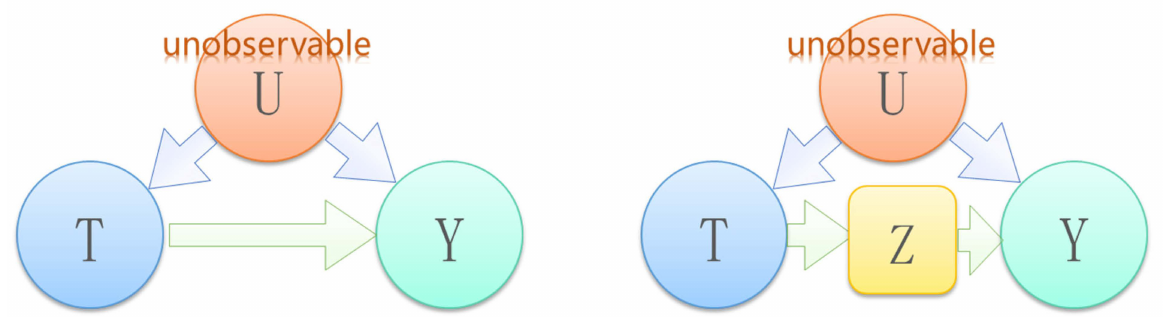
Figure 7. Front door criterion application